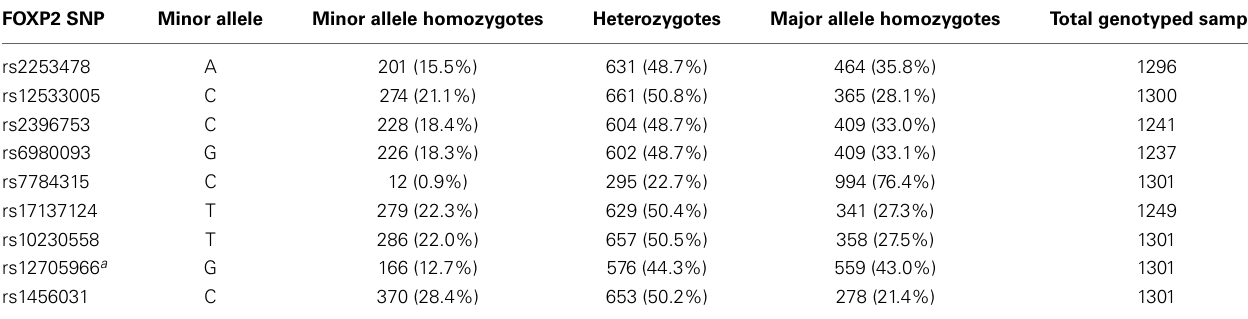
Table 2 | Genotype distribution of the study sample ( n =